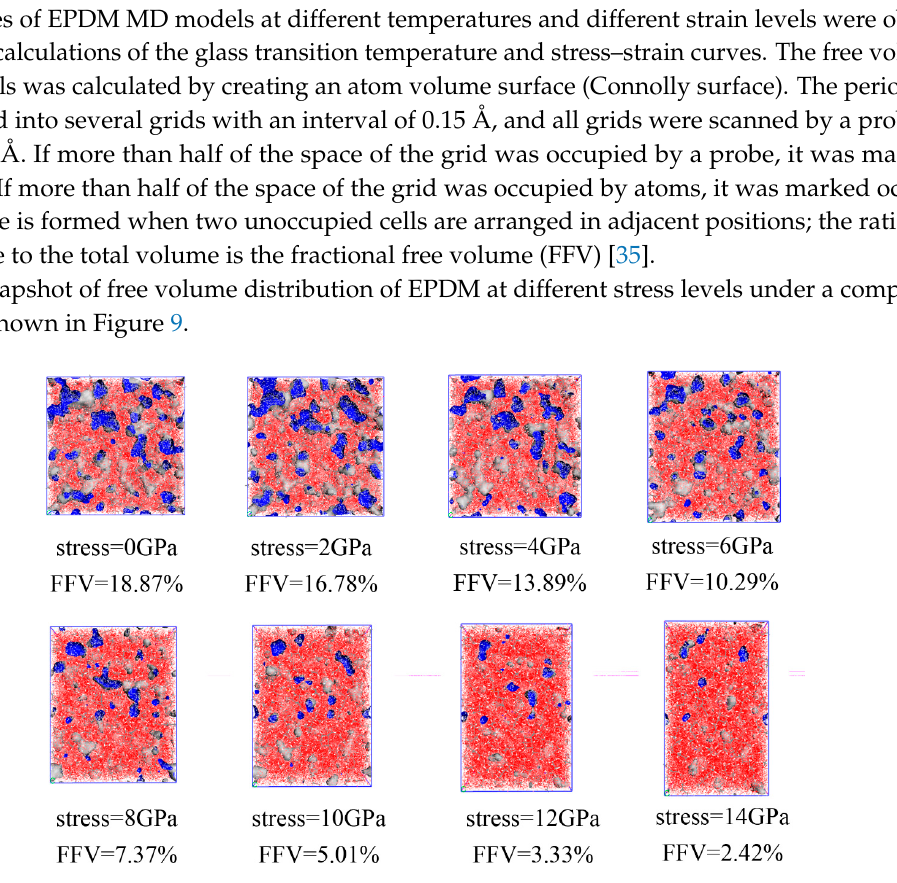
Figure 8. Connolly surface of a chlorine molecule.